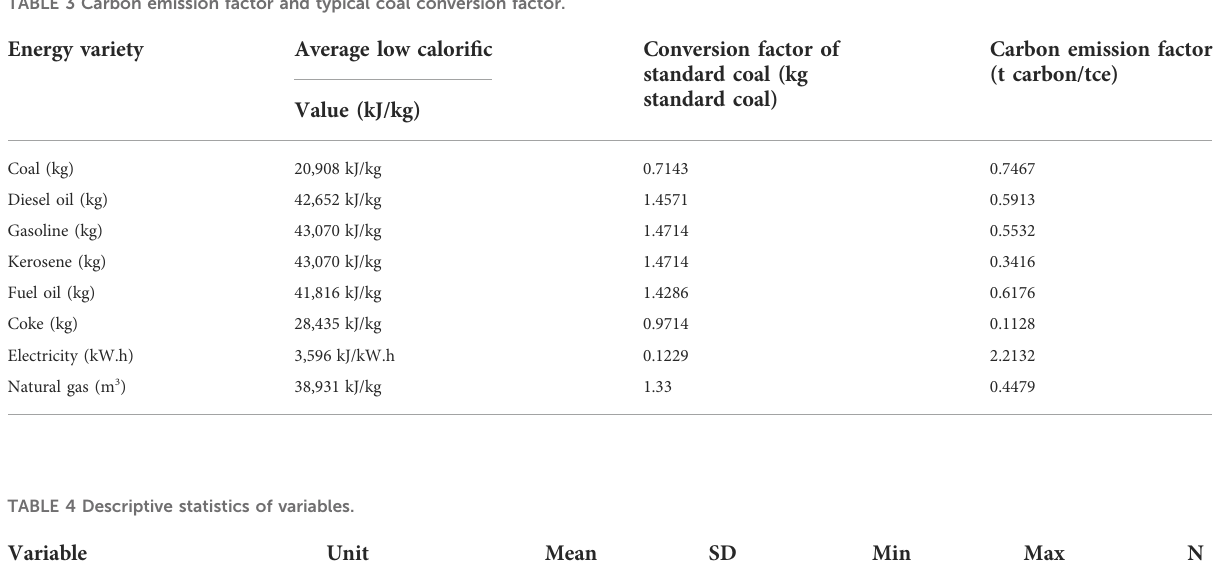
TABLE 3 Carbon emission factor and typical coal conversion factor.